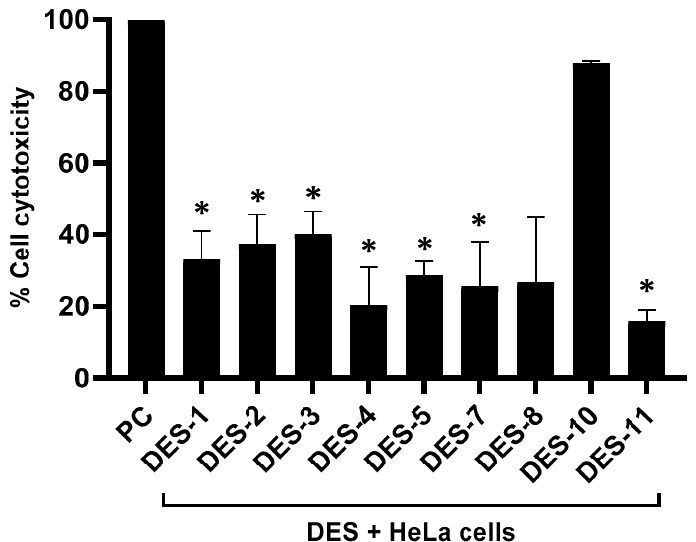
Figure 4. Deep eutectic solvents revealed limited cytotoxicity against HeLa cells. Human cells grown until confluence were treated with DES with 5% CO 2 and 95% humidity overnight at 37 ◦ C. Cells alone in serum-free RPMI and with 0.1% Triton X-100 were considered as negative and positive controls, respectively. Data were investigated with Graph PadPrism software (8.0.2). The data are presented as mean ± SE of several independent trials conducted in duplicates. (*) denotes p ≤ 0.05.